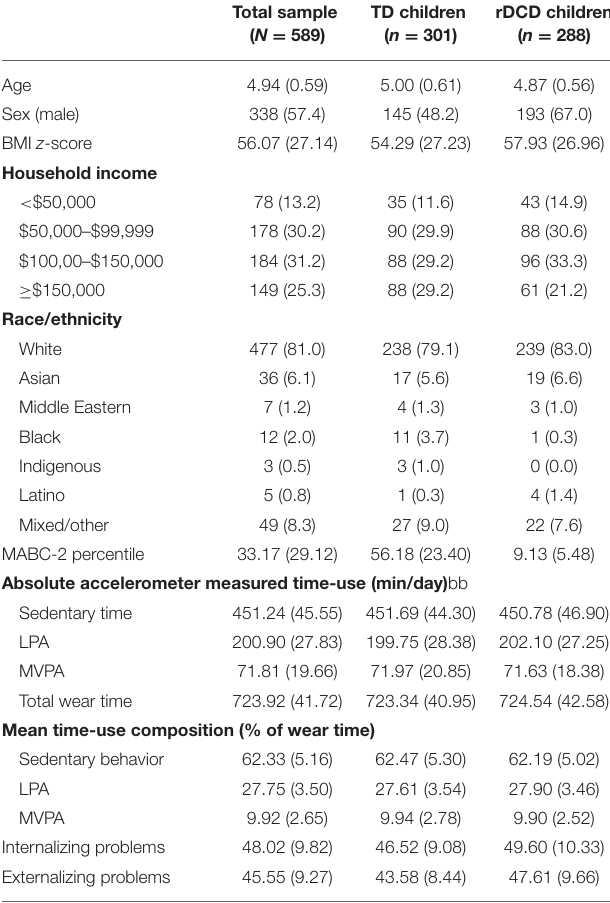
TABLE 1 | Descriptive statistics for demographic, behavioral, and mental health